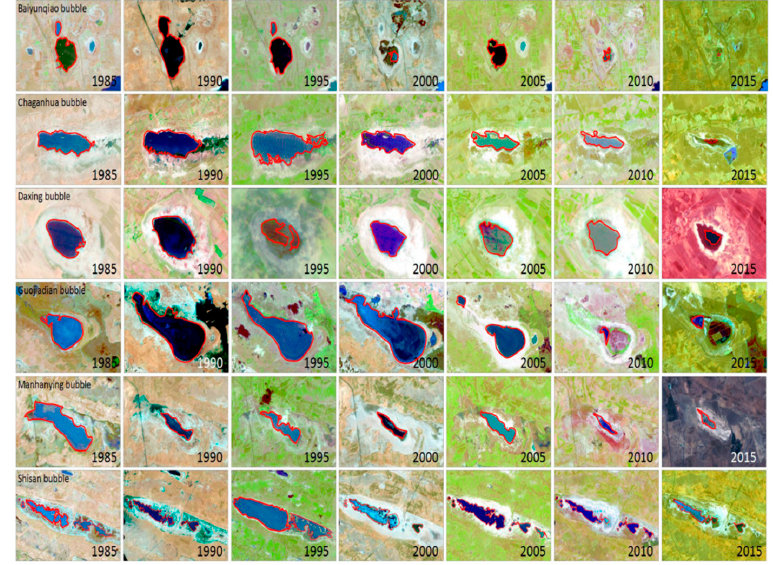
Figure 3. The remote sensing images of six typical lakes (Baiyunqiao Pao, Chaganhua Pao, Daxing Pao, Guoguojiadian Pao, Manhanying Pao, Shisan Pao) were selected from the study area to show changes over the past 30 years.